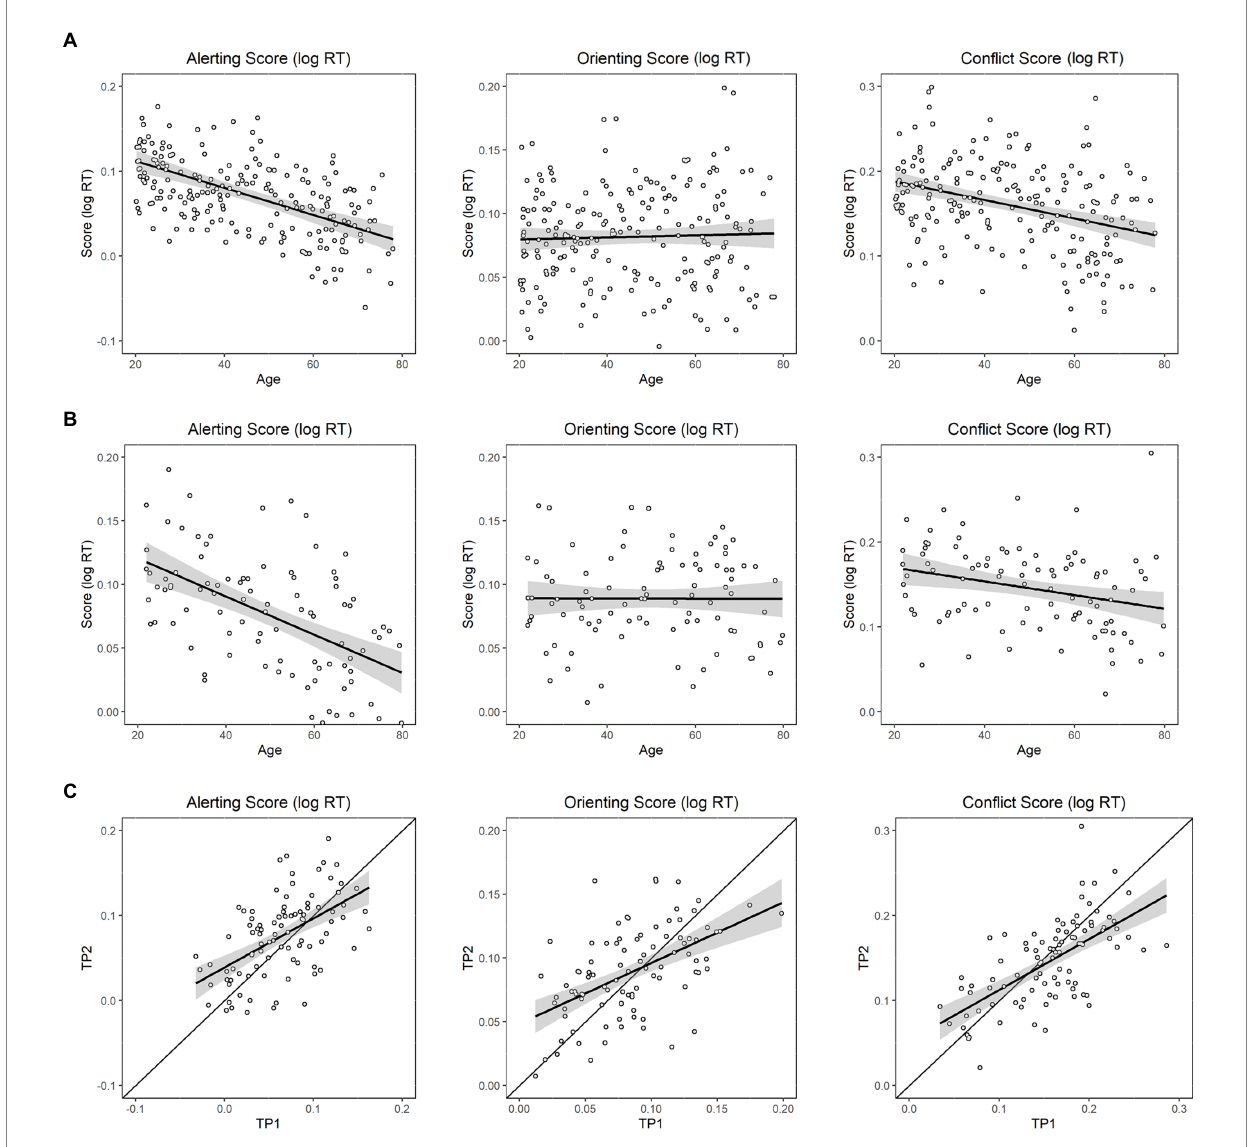
FIGURE 2 Linear effects of age on the efficiencies of the three attention networks. (A) In the baseline session, left panel: Effect on the efficiency of the alerting network; middle panel: Effect on the efficiency of the orienting network; right panel: Effect on the efficiency of the executive (conflict) network; (B) In the follow-up session, left panel: Effect on the efficiency of the alerting network; middle panel: Effect on the efficiency of the orienting network; right panel: Effect on the efficiency of the executive (conflict) network; (C) Modified Brinley plots for each attentional network (left panel: alerting; middle panel: orienting; right panel: conflict network). The X-axis denotes baseline, and Y-axis denotes follow-up. Scatterplots denote each data point for each individual. The best-fitting regression lines with confidence intervals are shown against the diagonal